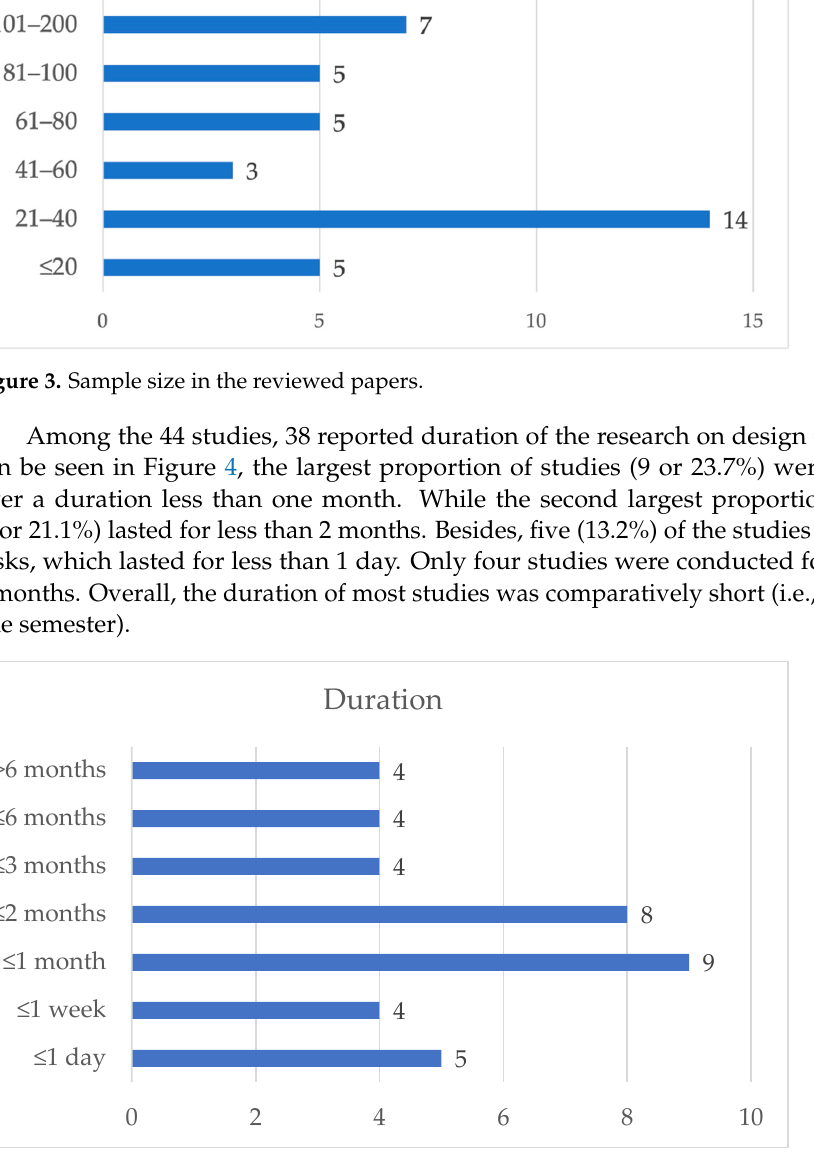
Figure 4. Duration of the reviewed papers.